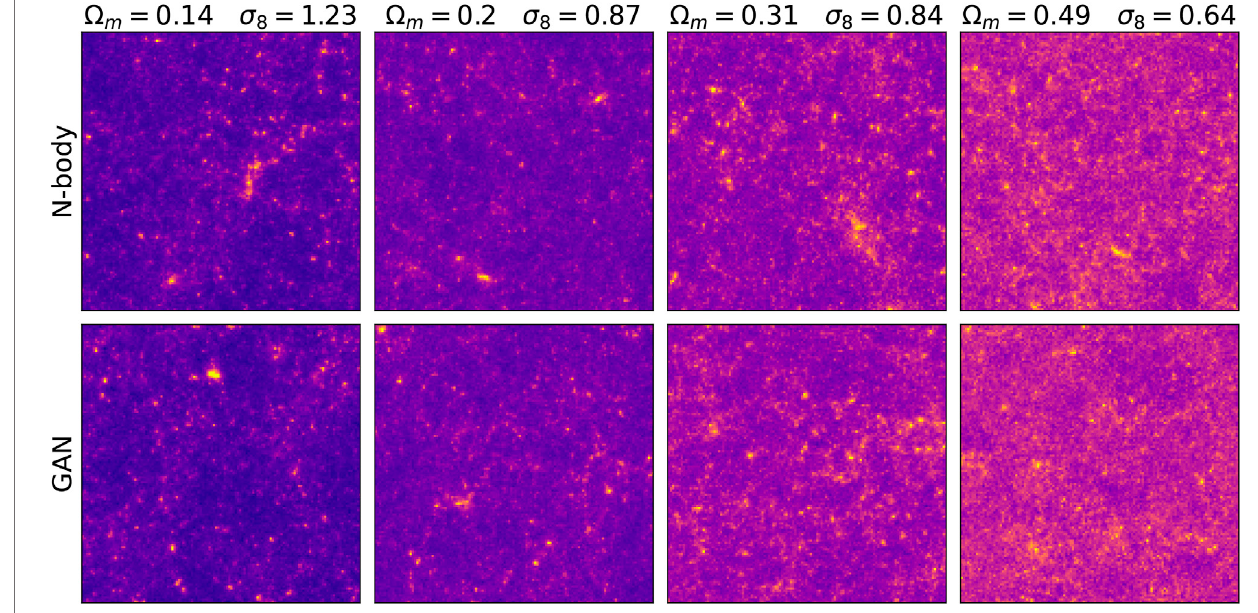
FIGURE 3 | The original N-body images and GAN-generated images for four cosmological parameter